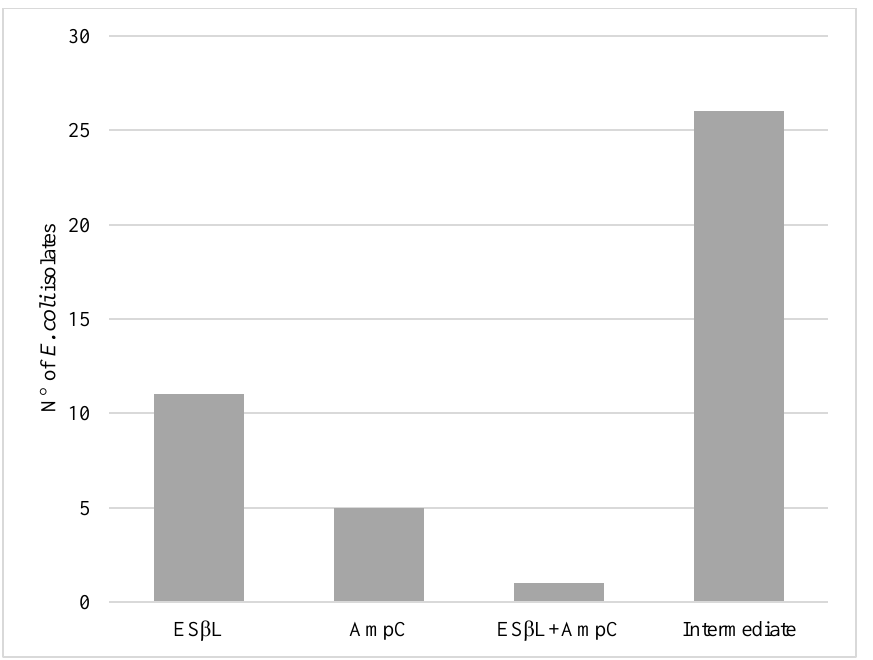
Figure 2. Number of ESβL, AmpC and ESβL + AmpC E. coli isolated from fresh wild boar meat samples and isolates with the intermediate profile in screening test for CTX and CAZ. Table 1. Distribution and combination of ESβL and AmpC genes in E. coli isolated from pork and wild boar meat products (phenotypically confirmed ESβL, ESβL + AmpC and AmpC).